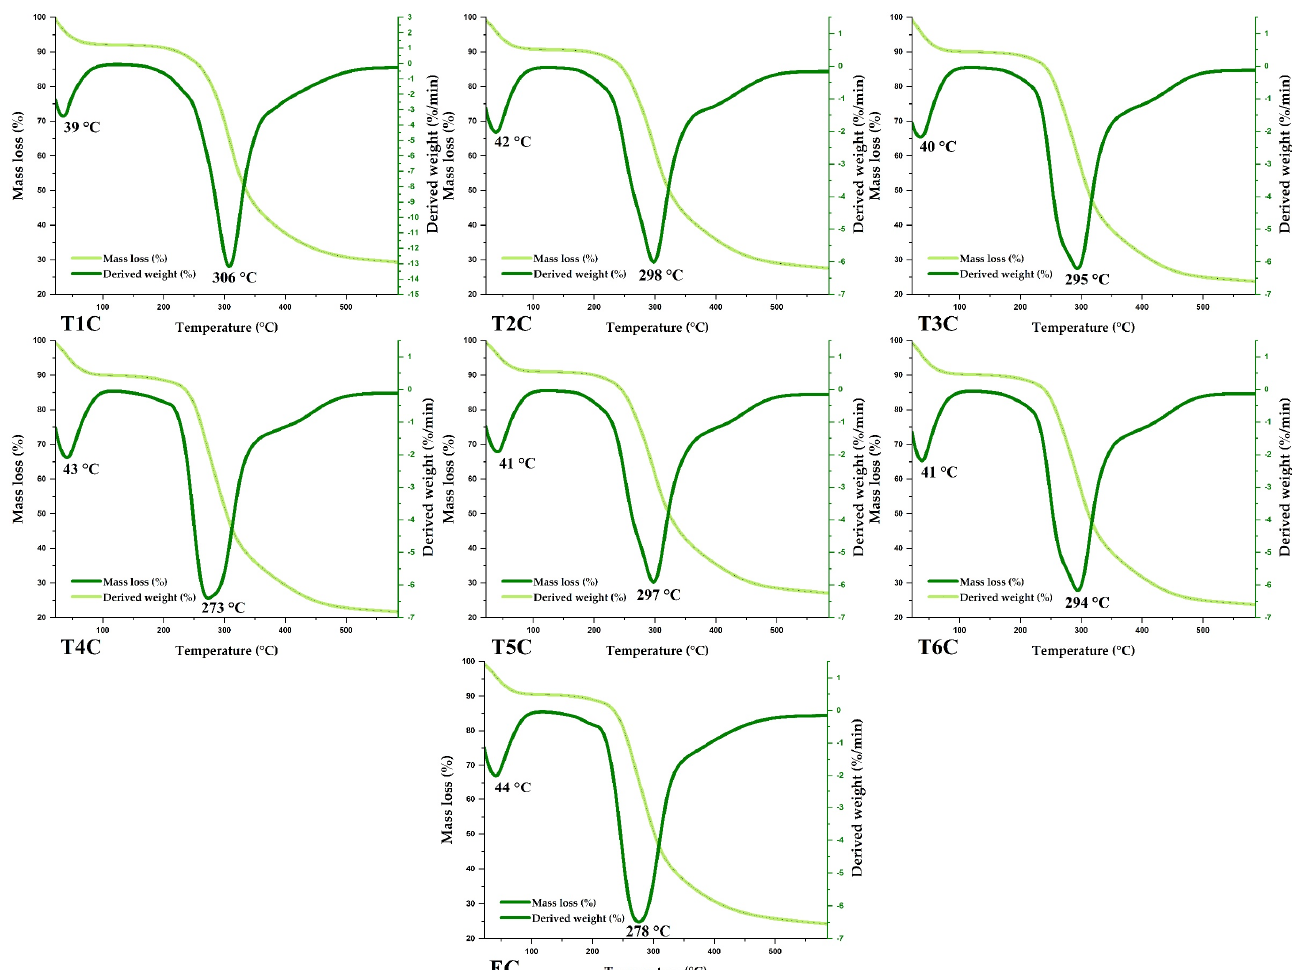
Figure 8. TG and DTA of encapsulated at 120 °C (T1C, T2C, and T3C) and 140 °C (T4C, T5C, and T6C), and erythrocytes (EC).